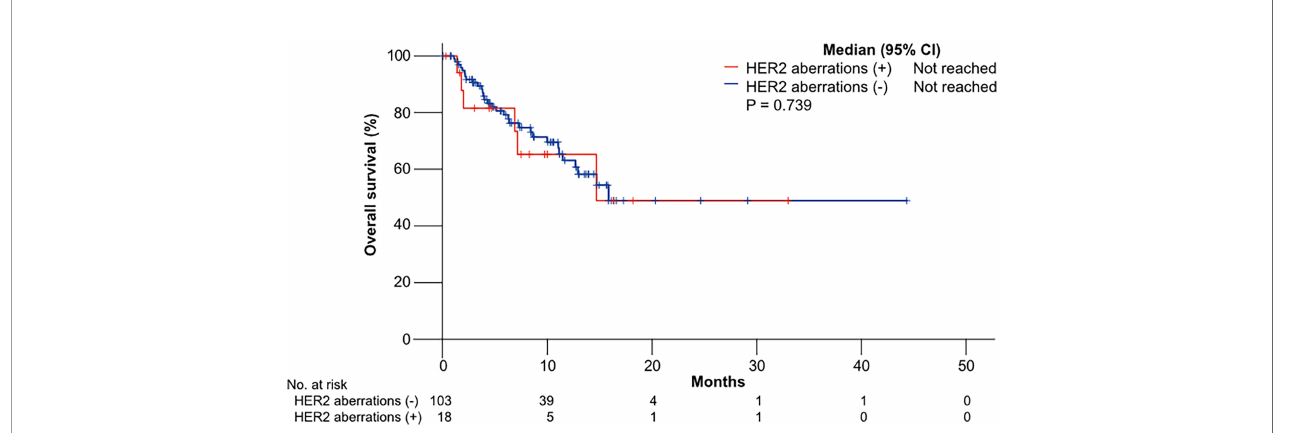
FIGURE 2 | Kaplan – Meier curves of overall survival (OS) to gemcitabine plus cisplatin according to HER2 aberrations.